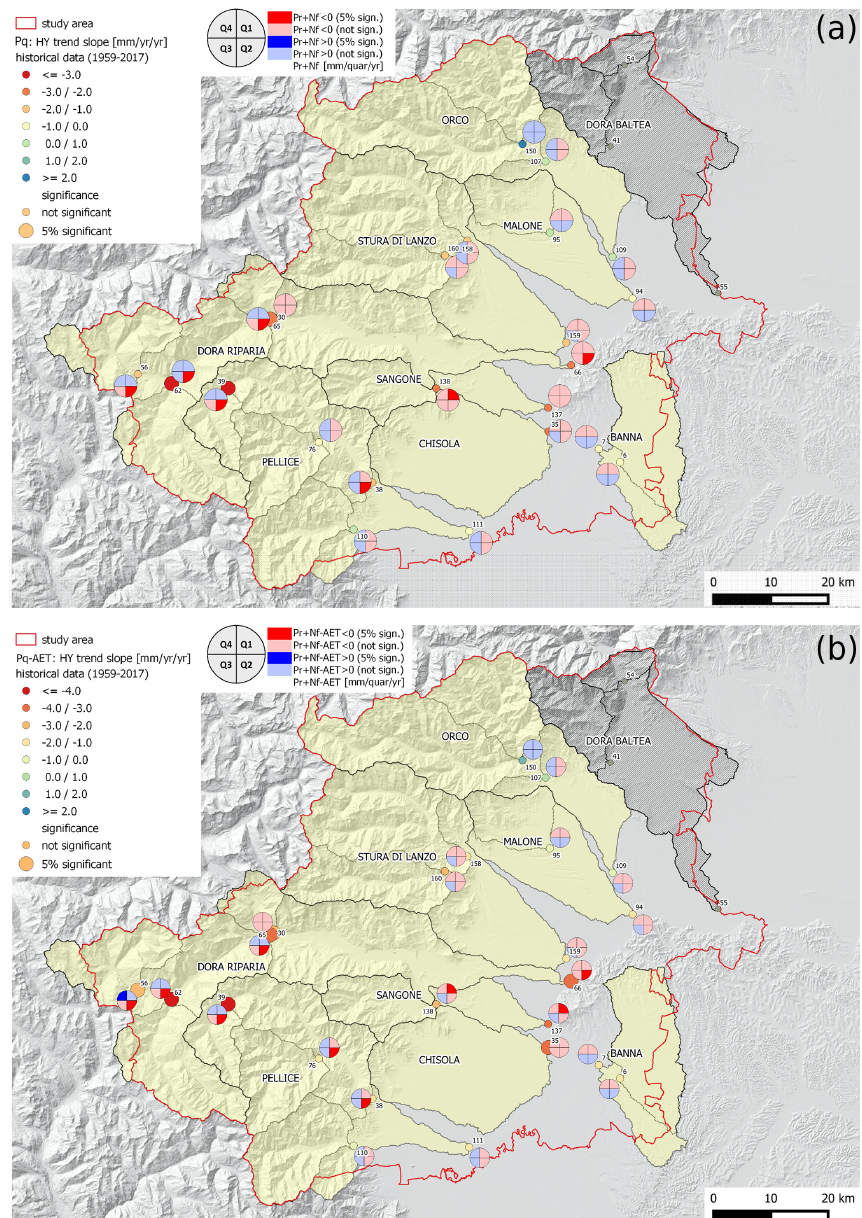
Figure 6. Trend slope at the catchment level for all studied catchments. (a) Total precipitation and (b) drainage. Hydrological year (full dots) and quarterly trend values (four-segments circles) are jointly represented, and trend significance is also indicated. When quarters are considered, the precipitation is the sum of liquid precipitation P r and melted snow N f . Topographic shading is based on DEM data from the Risknat project – “Base topografica transfrontaliera, ARPA Piemonte” (http://webgis.arpa.piemonte.it/ags101free/rest/services/topografia_ dati_di_base/Sfumo_Europa_WM/MapServer, last access: 14 August